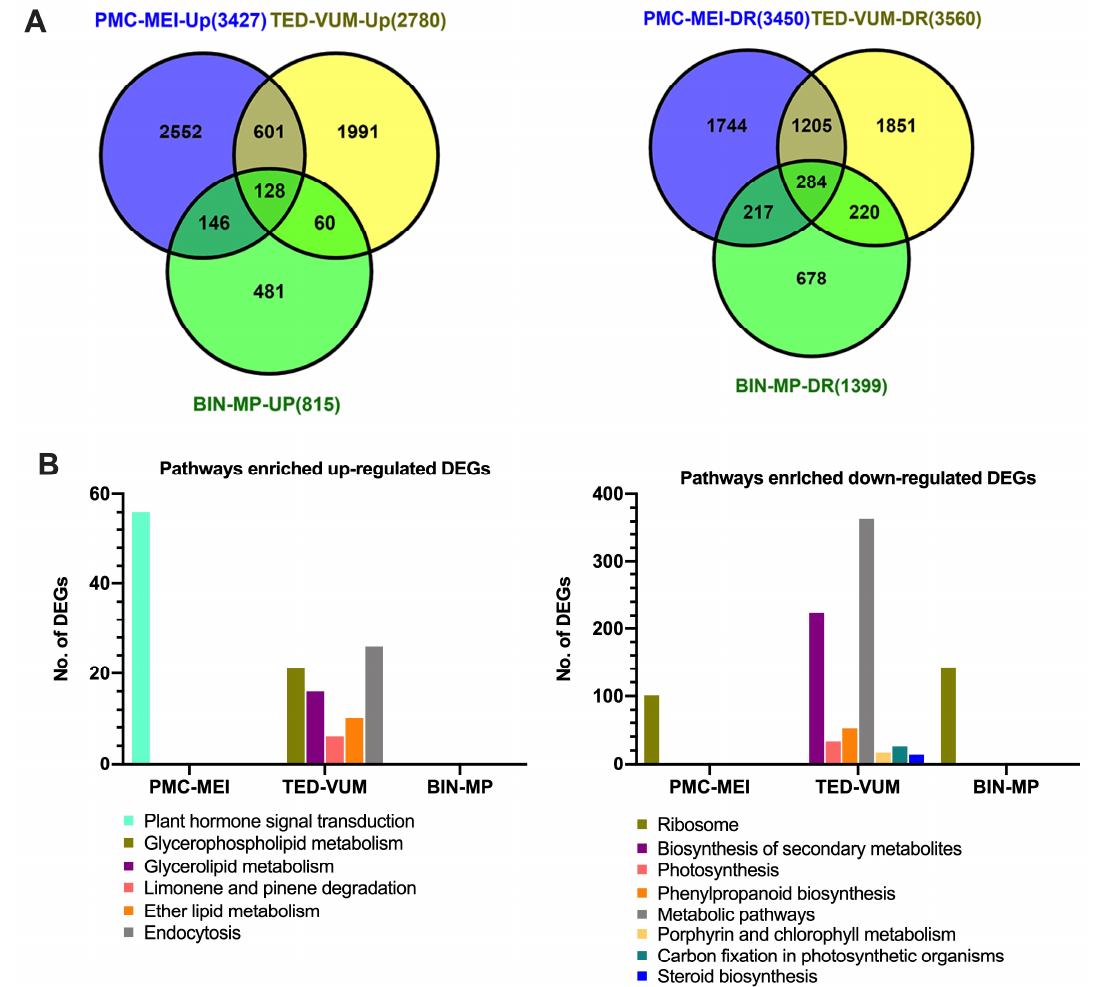
Figure 4. Drought-responsive genes in three groups of anthers of different developmental stages in tomato. ( A ) Venn diagram analyses of DEGs Up-regulated ( left ) and down-regulated ( right ) by drought stress in each group. ( B ) Significantly enriched KEGG pathways in DEGs Up- and down-regulated by drought stress in each group.